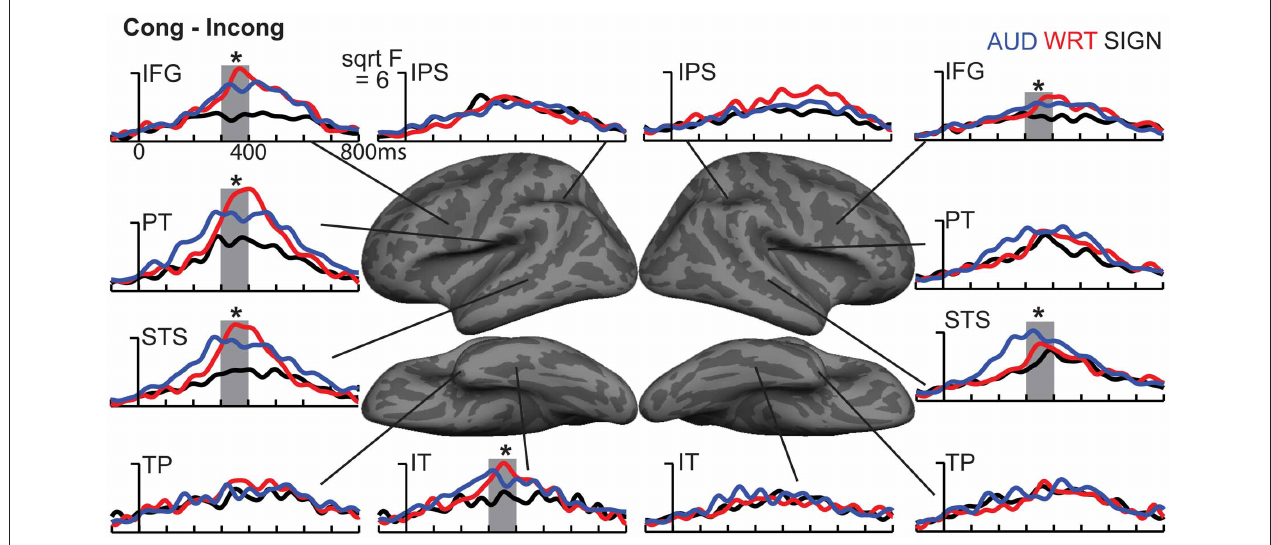
FIGURE 7 | ROI timecourses for the Congruent-Incongruent subtraction across each language/modality. From 300 to 400ms (thick gray bars), auditory (blue lines) and written (red lines) words evoke stronger effects than